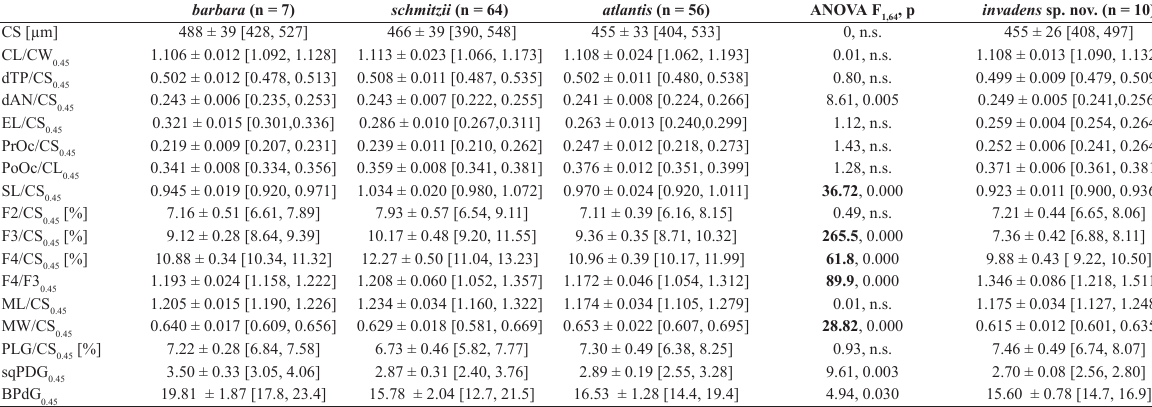
Table 1. RAV-corrected morphometric data of worker individuals of the Plagiolepis schmitzii complex given as arithmetic mean±- standard deviation [minimum, maximum]; n = number of individuals. F values and significance levels p are from a univariate ANOVA and evaluate the differences between Pl. atlantis and Pl. invadens sp.